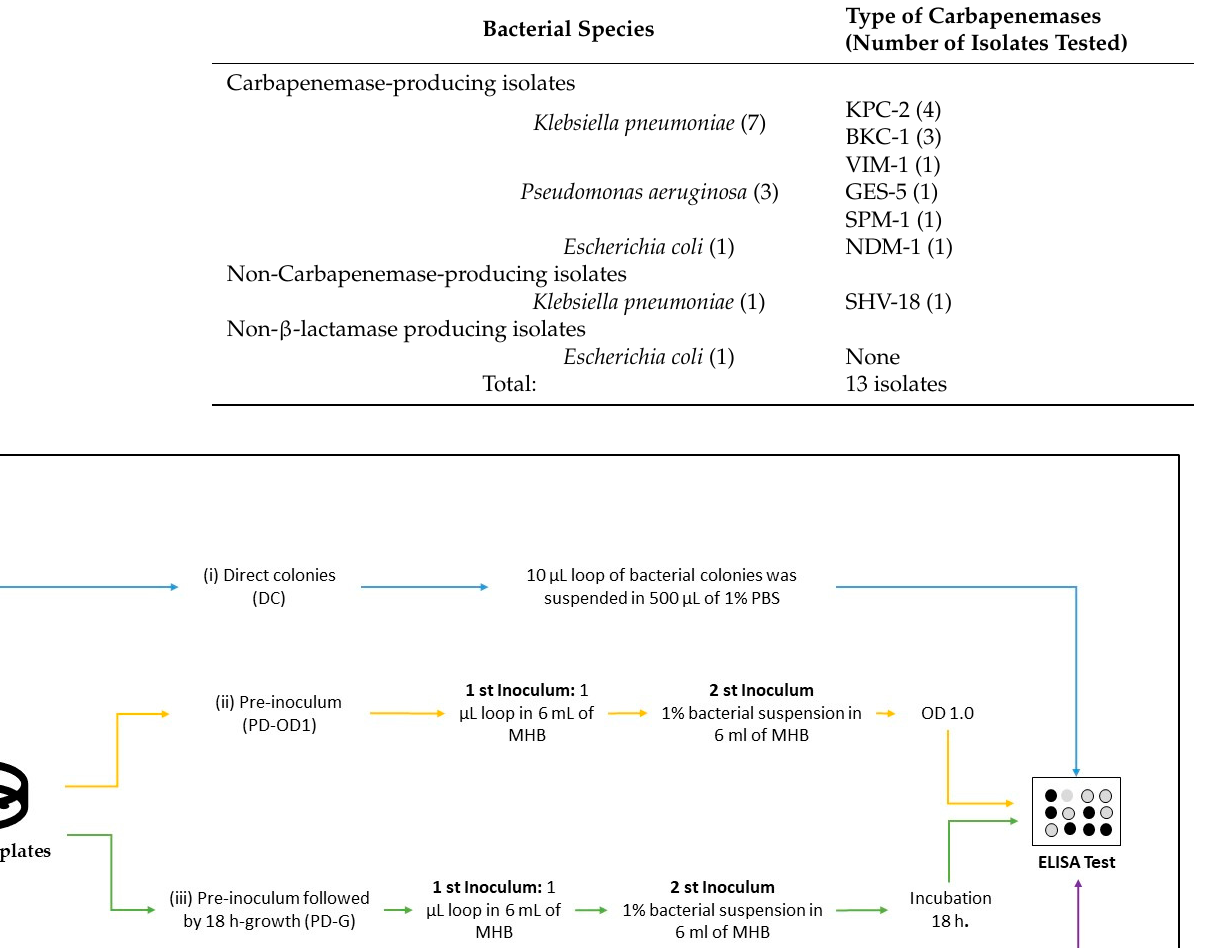
Table 1. Isolates used for screening protocol.